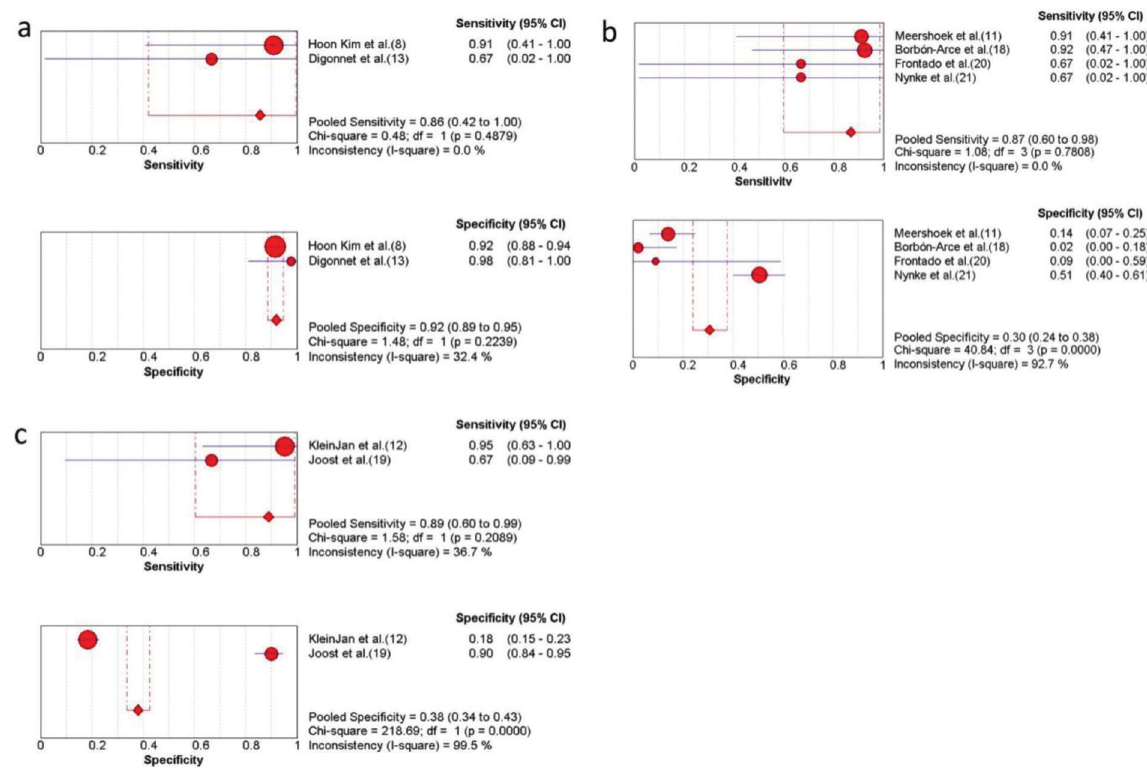
Figure 5 - Subgroup analysis of ICG combined with other detection methods. (a) The sensitivity and specificity of only free ICG NIR fluorescence imaging; (b) the sensitivity and specificity of the ICG- 99m Tc- nanocolloid; (c) the sensitivity and specificity of ICG combined with blue dye and the ICG- 99m Tc- nanocolloid. CI, confidence interval; ICG, indocyanine green; NIR,